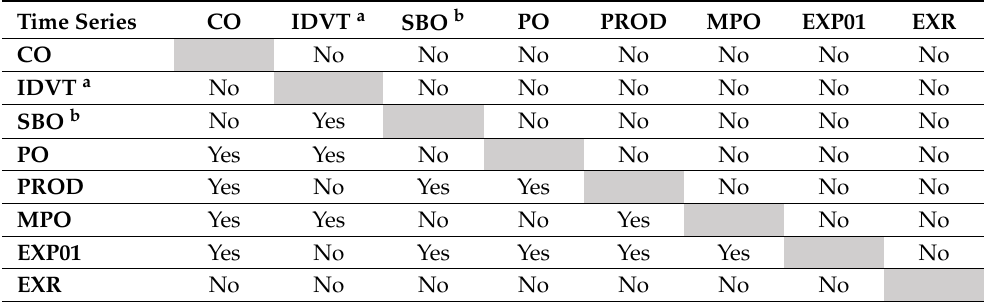
Table 2. Causality relationship between the variables, based on the literature and theories. Time